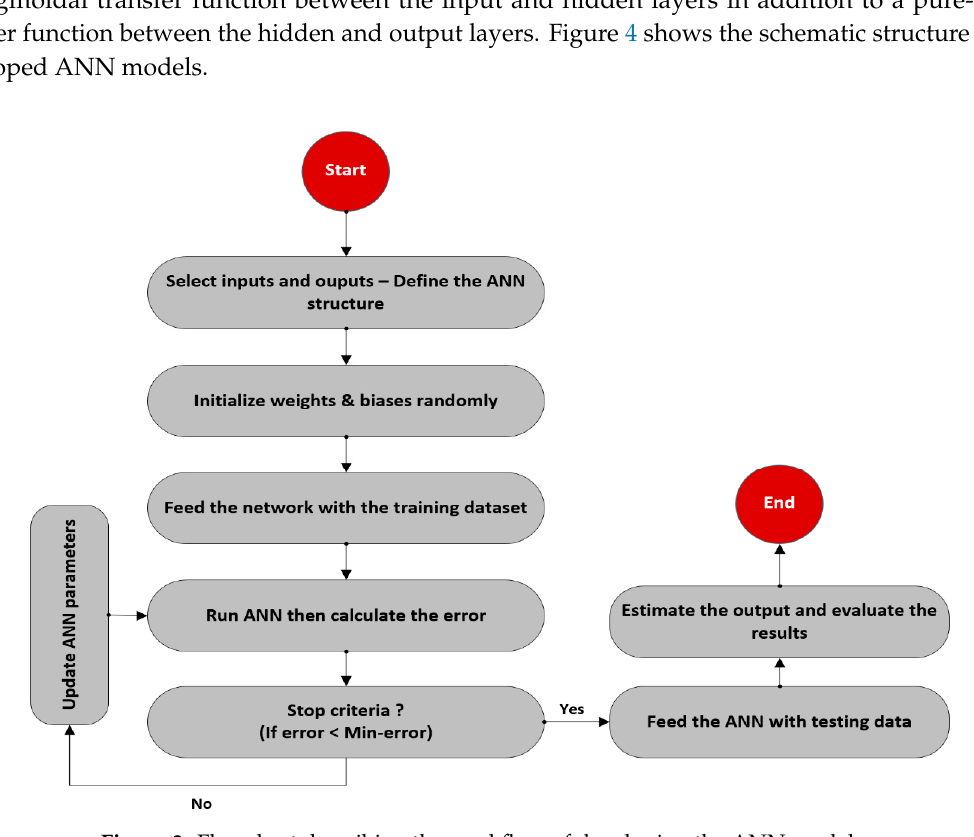
Figure 4. Typical schematic structure for the developed ANN models for predicting the rheological properties of HBM.